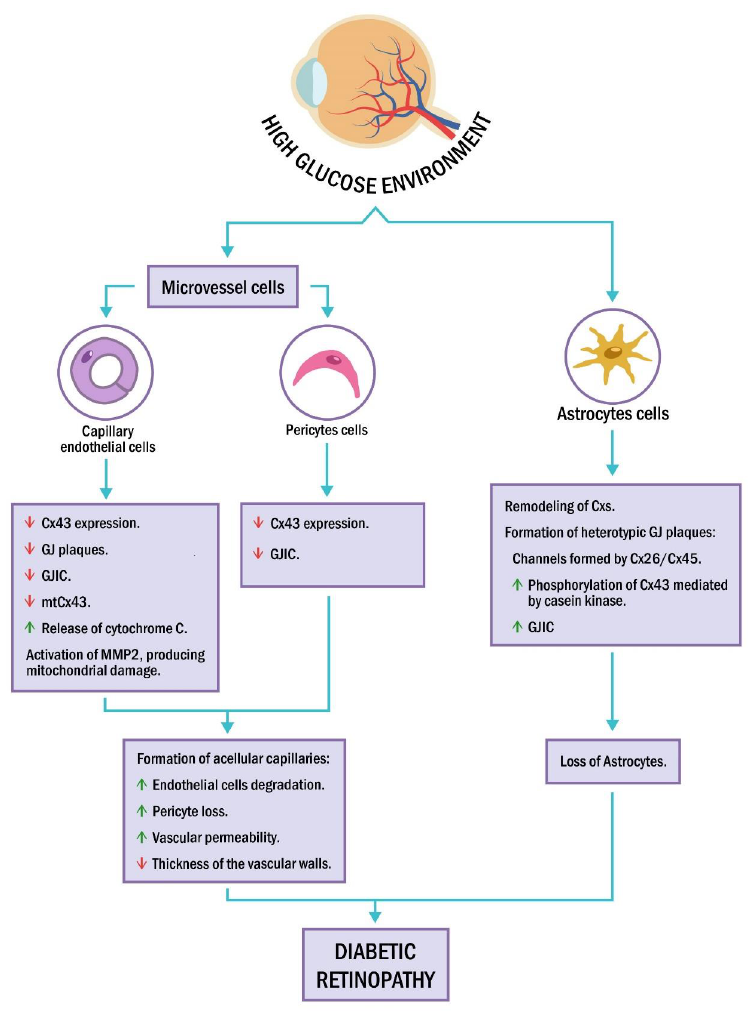
Figure 3. Connexin alterations reported in capillary endothelial cells, pericytes, and astrocytes during diabetic retinopathy (DR) in high glucose cellular environments.